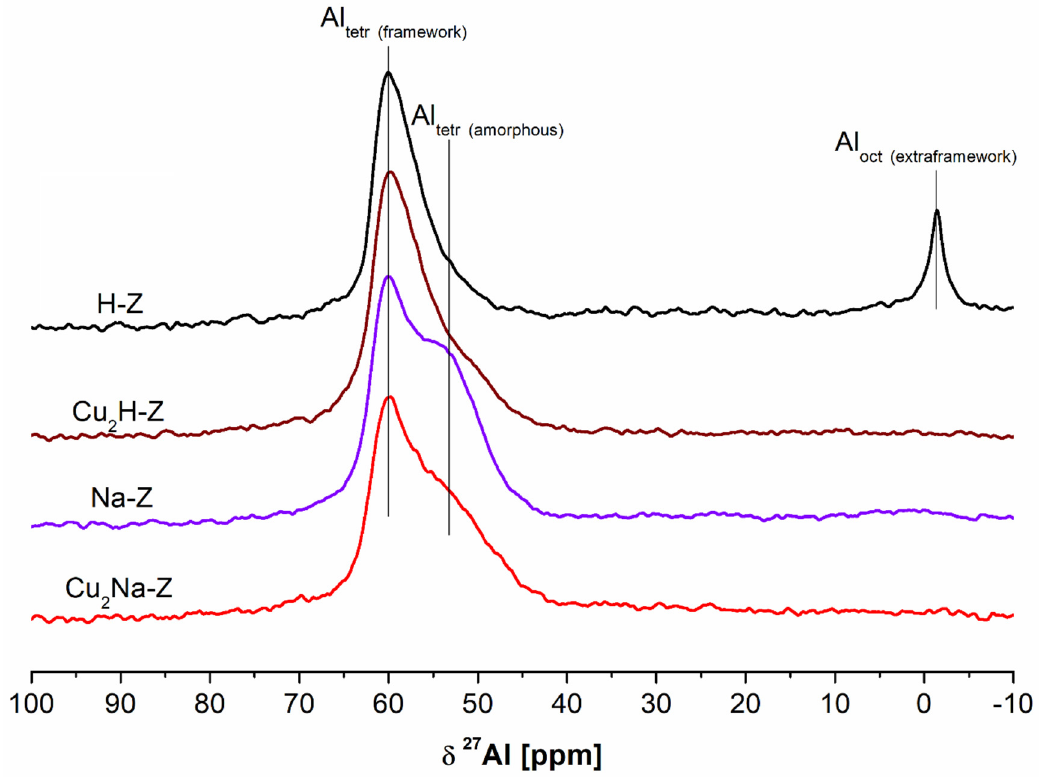
Figure 3. 27 Al NMR spectra of different prepared samples.